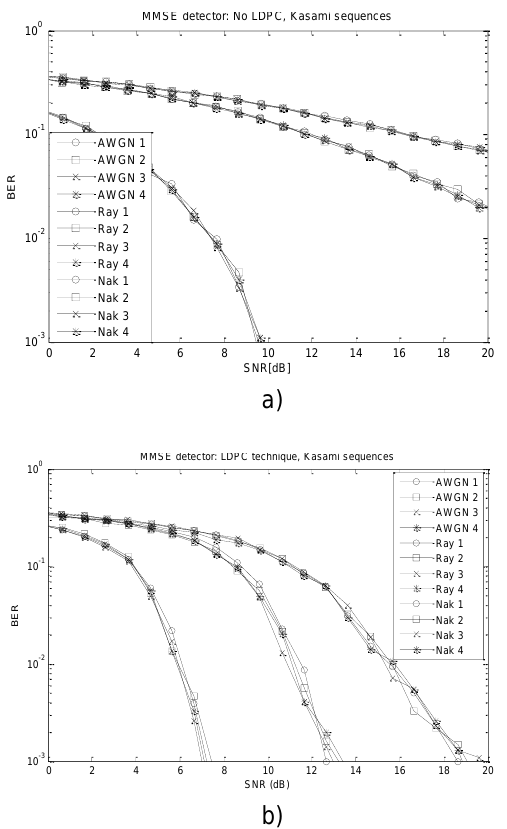
Figure 3 – BER vs SNR: Kasami sequences (a) No LDPC (b) LDPC technique